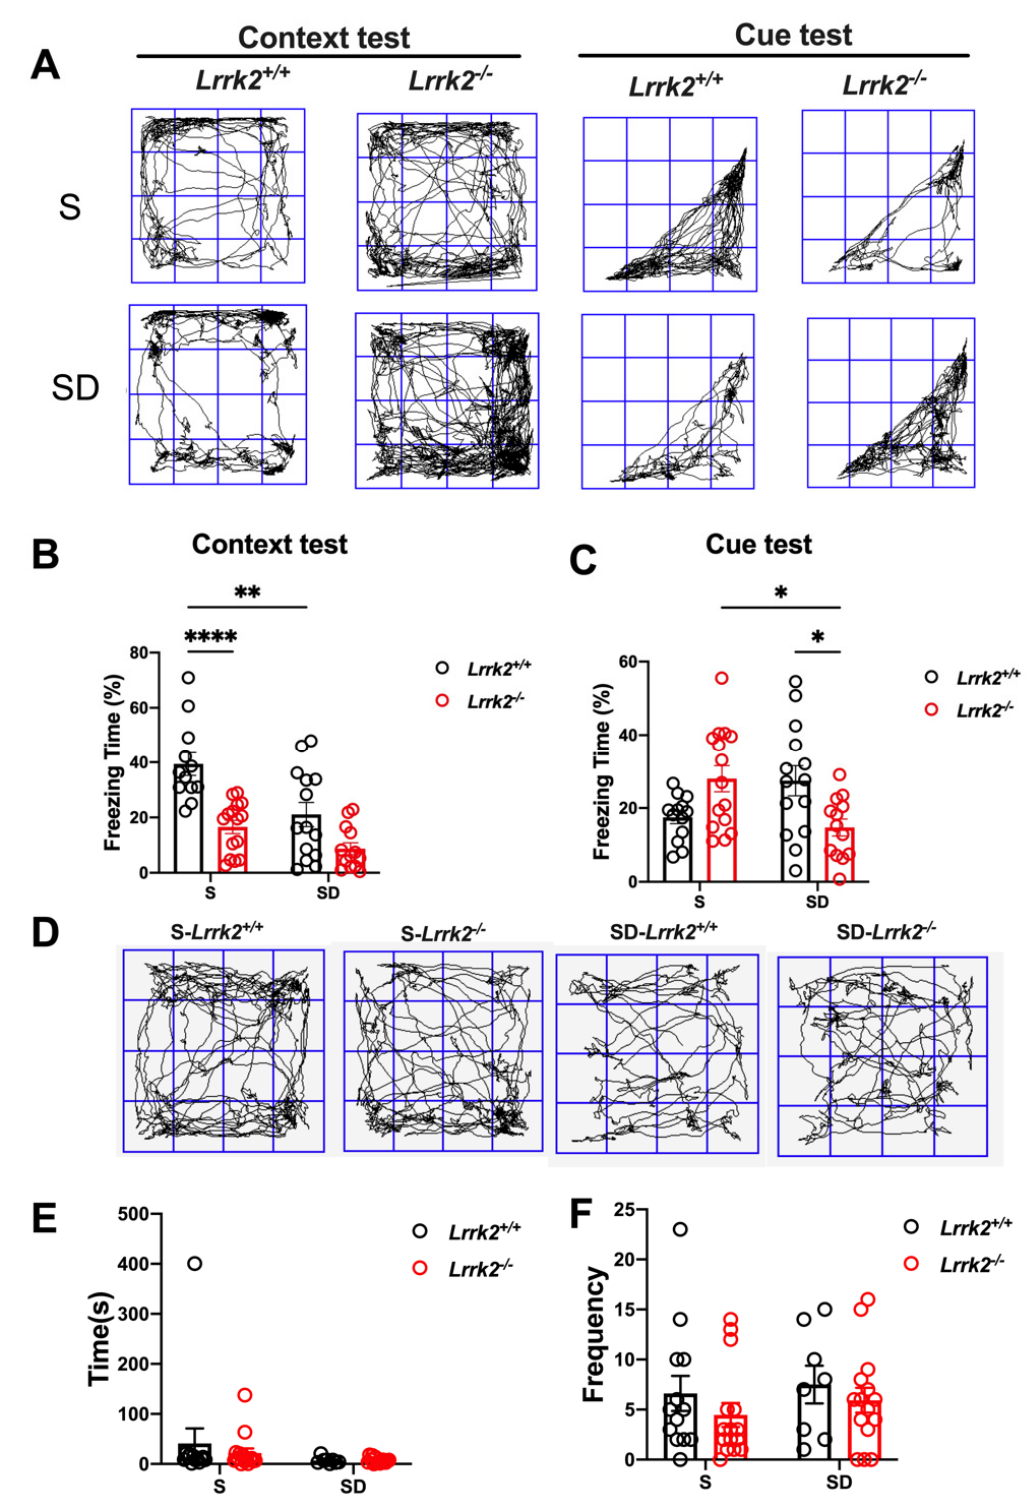
Figure 5. The abnormalities in short-term memory induced by LRRK2 deficiency. ( A ) Fear condi- tioning test, training track diagram; N = 13 and 14, respectively for 13-month-old S- Lrrk2 +/+ and SD- Lrrk2 +/+ mice; N = 15 and 12, respectively for 13-month-old S- Lrrk2 -/- and SD- Lrrk2 -/- mice. ( B , C ) Data are presented as mean ± SEM. * p < 0.05, ** p < 0.01, **** p < 0.0001, by Unpaired t test. ( D ) Representative traces of the open field test. ( E , F ) Data are presented as mean ± SEM and were analyzed by Tukey’s multiple comparisons